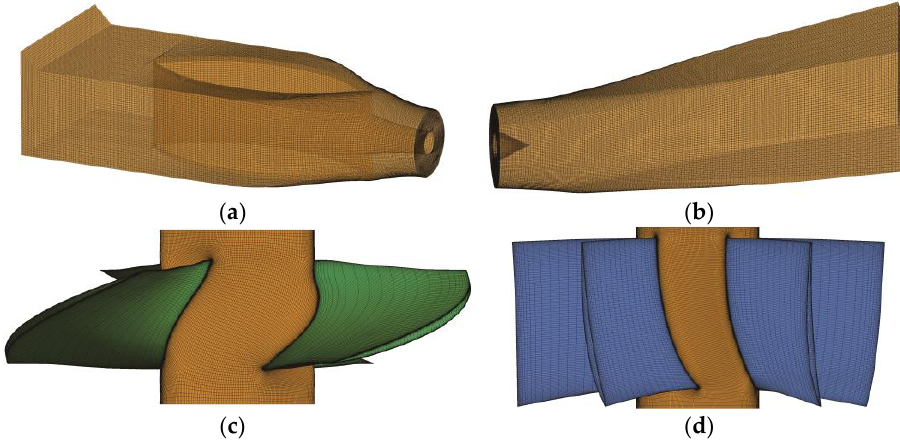
Figure 3. Grid diagram: ( a ) inlet passage; ( b ) outlet passage; ( c ) impeller; ( d ) guide vane.